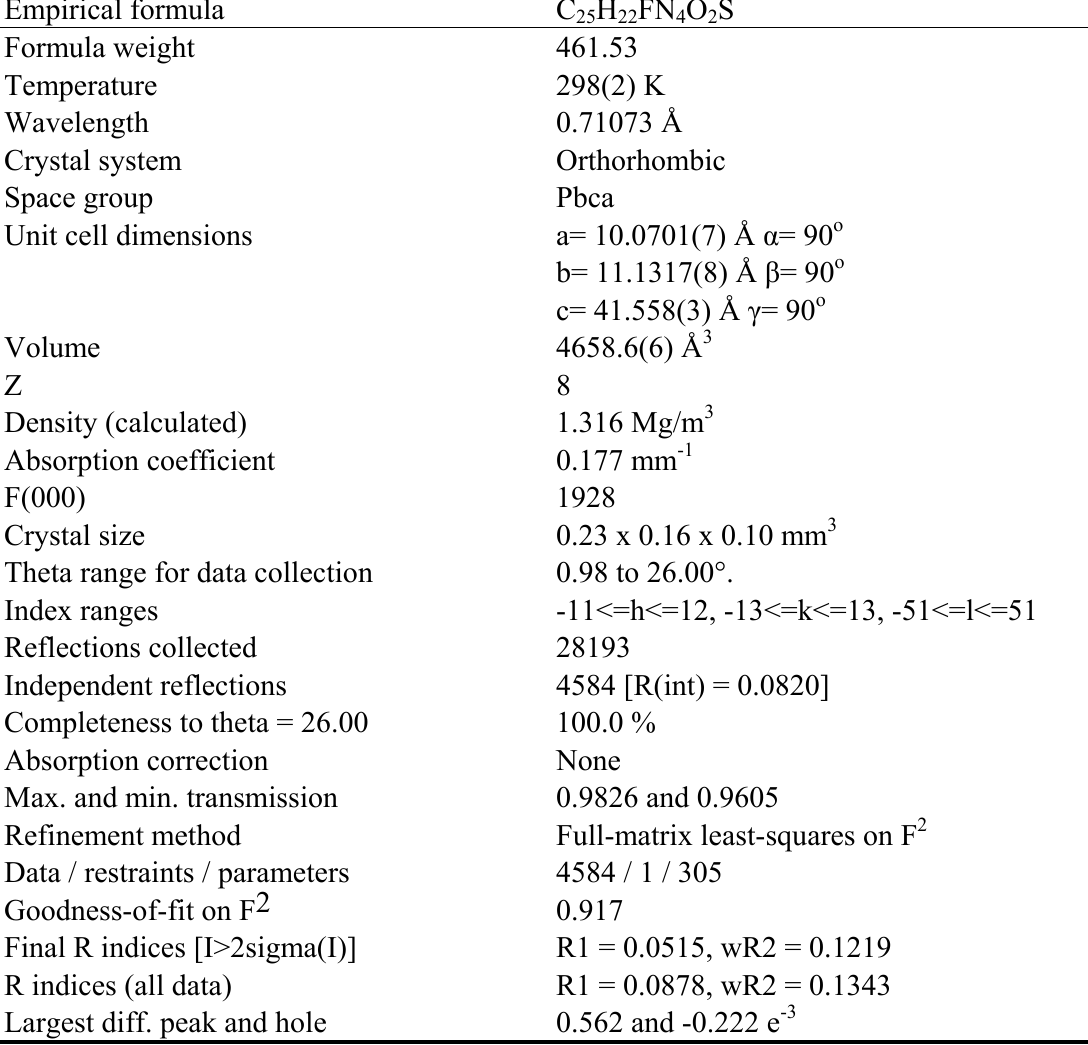
Table 1 . Summary of crystallographic data and parameters of compound 4j